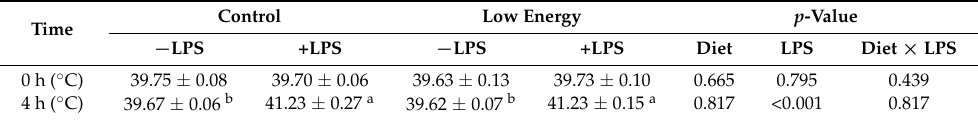
Table 9. Effect of different energy levels during gestation on temperature of weaned piglets challenged with Escherichia coli lipopolysaccharide.